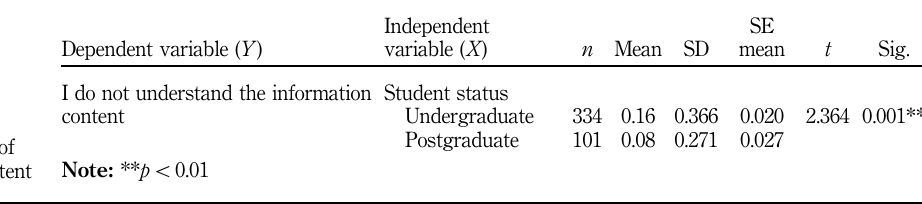
findings on comprehension of information